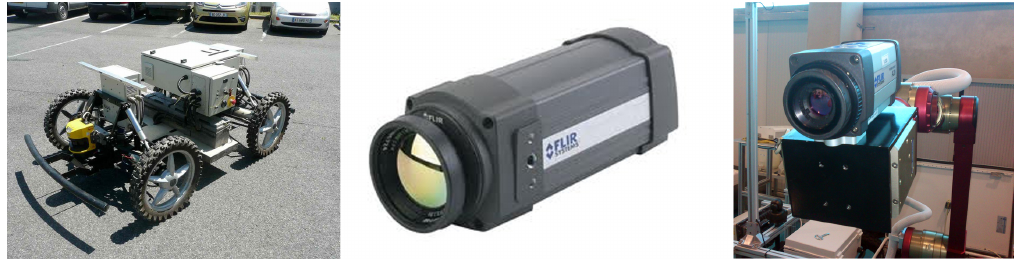
Figure 2. Robotic platform and thermographic